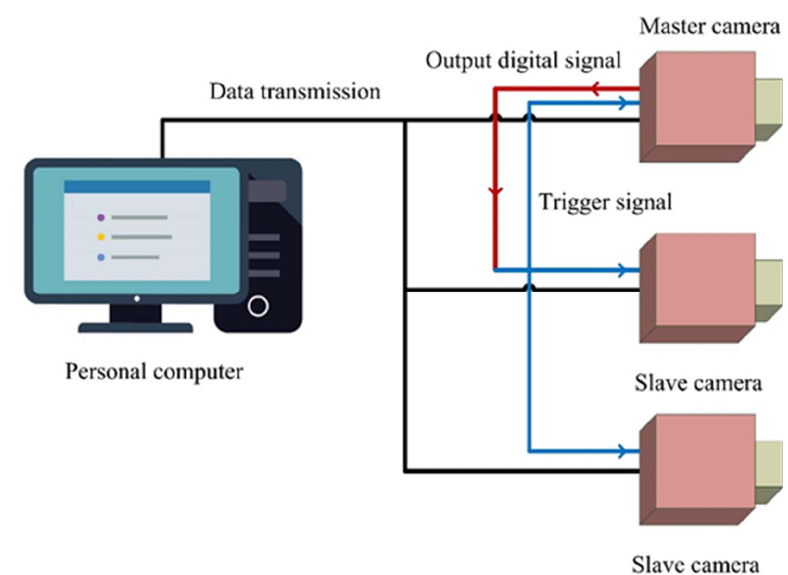
Figure 3. Synchronization procedure of the multi-camera vision system.